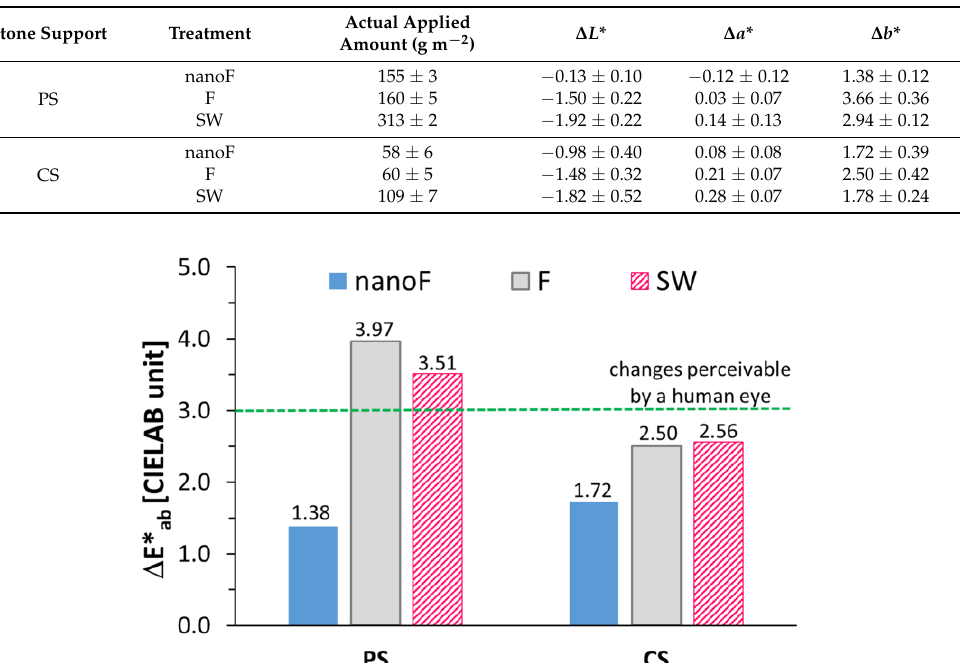
Table 4. Amount of applied product, color changes as variations of L *, a *, and b * measured before and after the coating application. The standard deviation is reported for each data set.